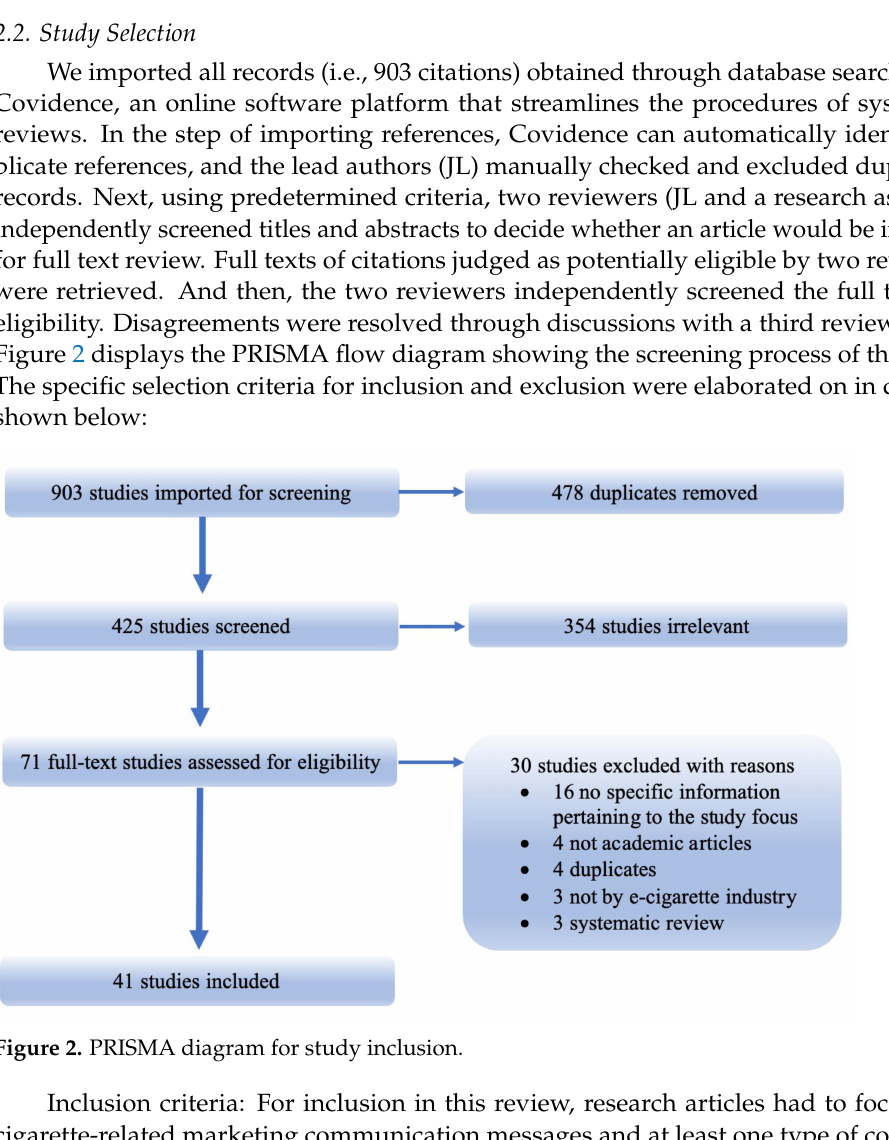
Figure 1. Five primary strategies in marketing communication.